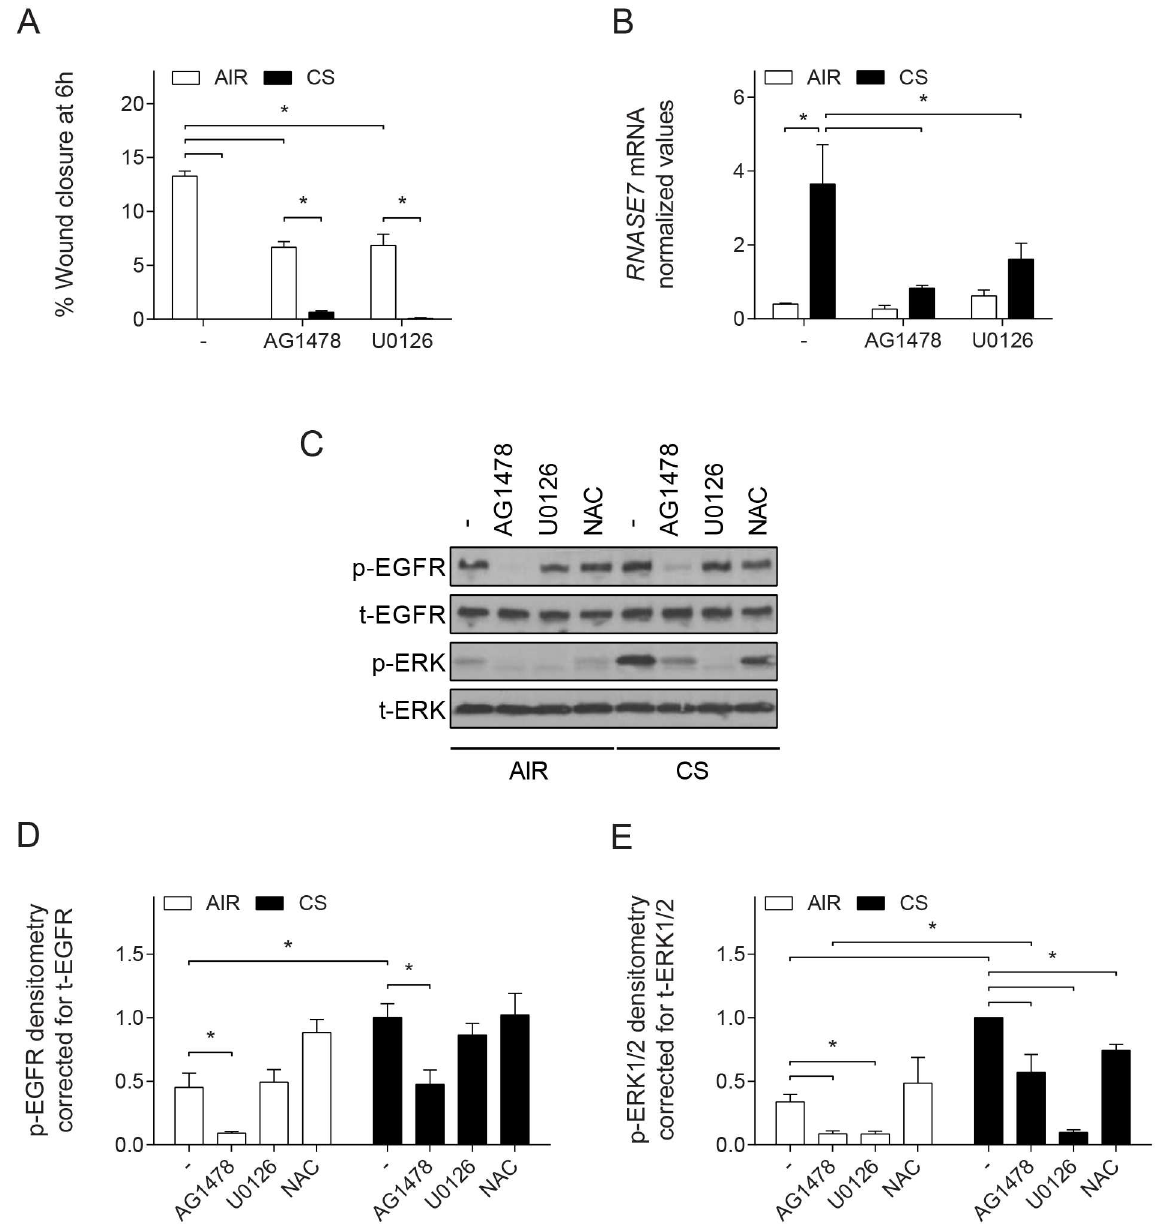
Fig 5. EGFR and ERK1/2 signaling in wounded ALI-PBEC. (A) Intrinsic wound healingof ALI-PBEC was determinedin the presence of the EGFR tyrosine kinase inhibitorAG1478 (1 μ M) or the MEK1/2 inhibitor U0126(25 μ M) at 6 h after exposure with either air or CS. Data are shown as percentage wound closure compared to t = 0 h. (B) mRNA expression of RNASE7 was determinedby qPCR. Data are shown as normalized mRNA expressioncompared to RPL13A and ATP5B . (C) Western blot analysis of EGFR and ERK1/2 phosphorylation of woundedALI-PBEC exposed to air or CS in the presence of AG1478, U0126, and NAC, at 6 h after exposure.(D) Bands were quantifiedby densitometryfor analysisof EGFR and (E) ERK1/2 phosphorylation and corrected for total-EGFR and total-ERK1/2, respectively. For all graphs data are shown as mean; error bars represent SEM; experiments were conductedin duplicate; n = 3 independent donors; * p < 0.05.